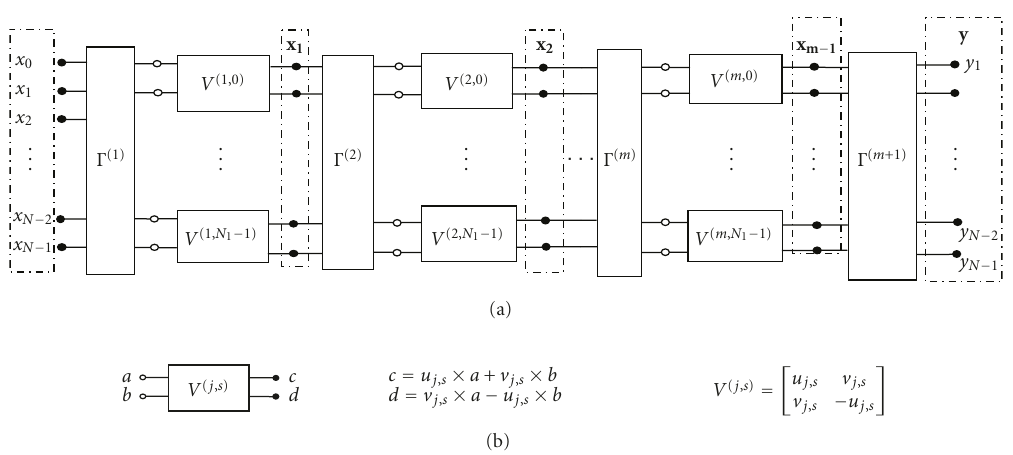
Figure 1: The unified flowgraph of fast transform algorithms: (a) flowgraph structure; (b) the basic (butterfly)